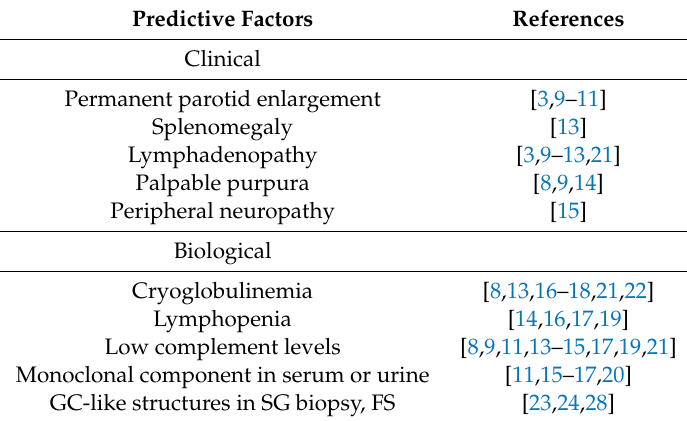
Table 1. Predictors of lymphoma development in